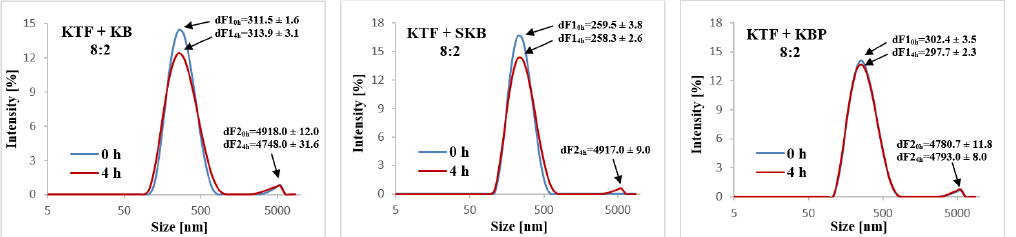
Figure 3. Distribution of the lipid droplets size for KTF and KB, SKB, and KBP combinations where second fraction of particles greater than 4 µm were observed.